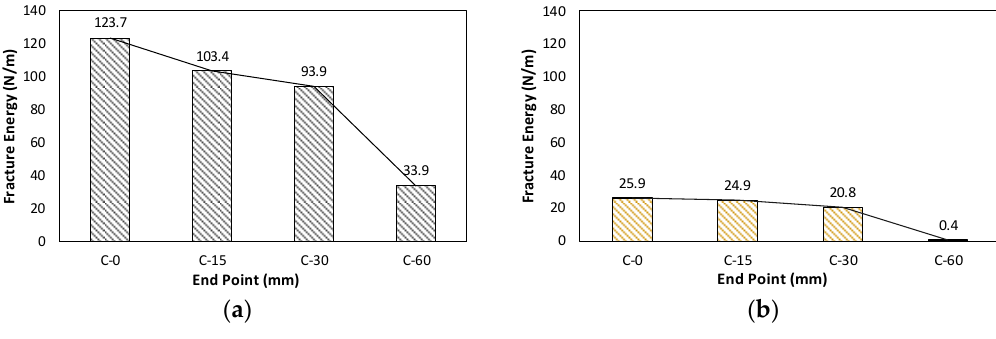
Figure 12. Comparison of G F , G f : ( a ) true fracture energy ( G F ); and ( b ) size effect fracture energy ( G f ). Table 2. Results of fracture tests for (C type of